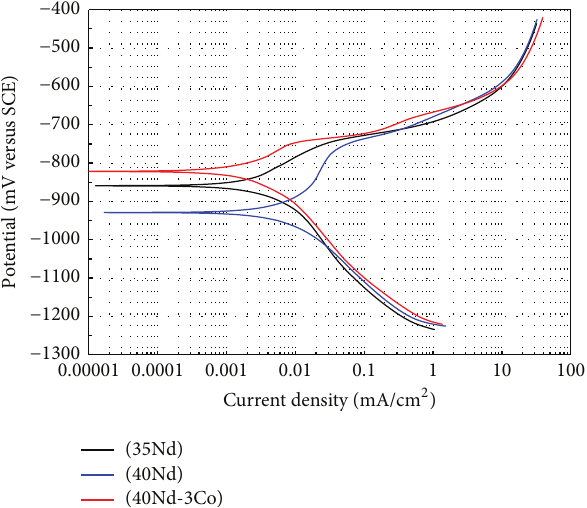
Figure 1: Potentiodynamic polarization curves of the Nd magnets tested in 3.5% NaCl solution at 25 ∘ C.